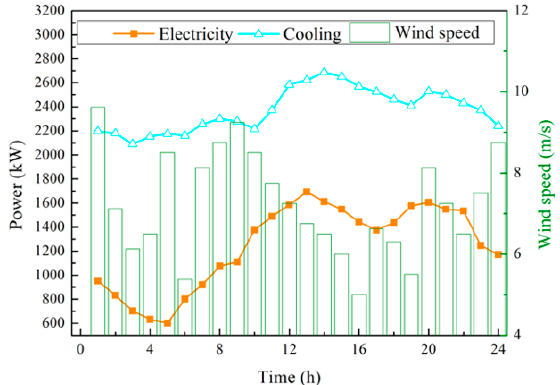
Figure 5. Inputting data in summer.